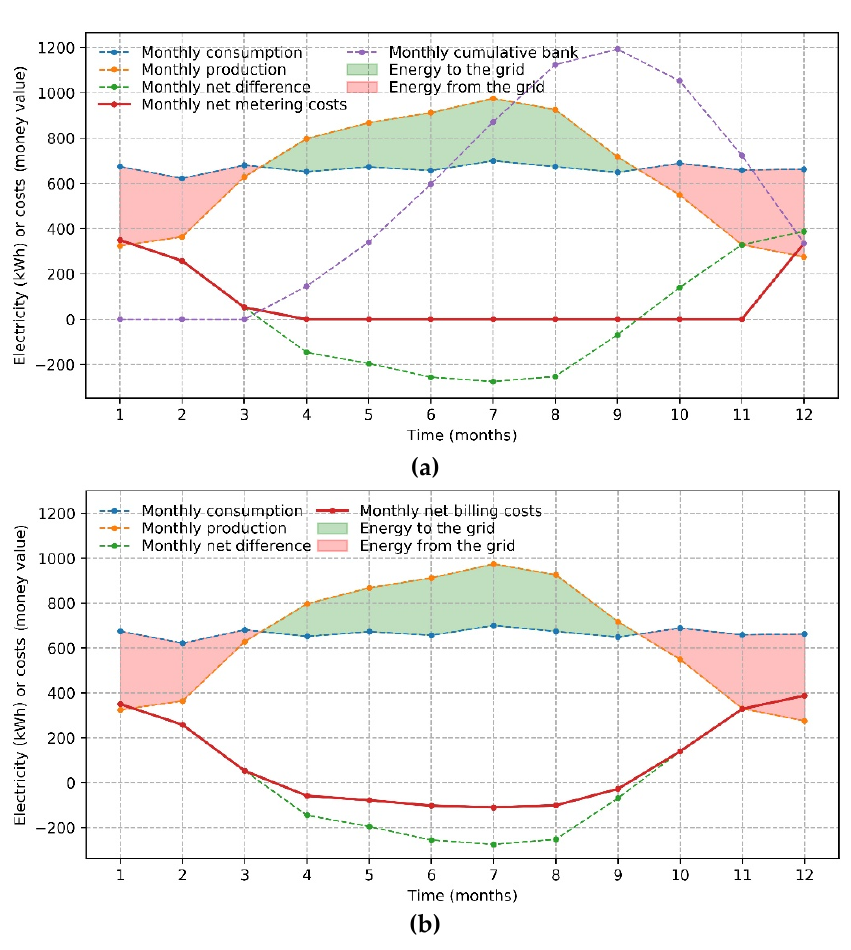
Figure 6. ( a ) Net metering type of cost calculation. ( b ) Net billing type of cost